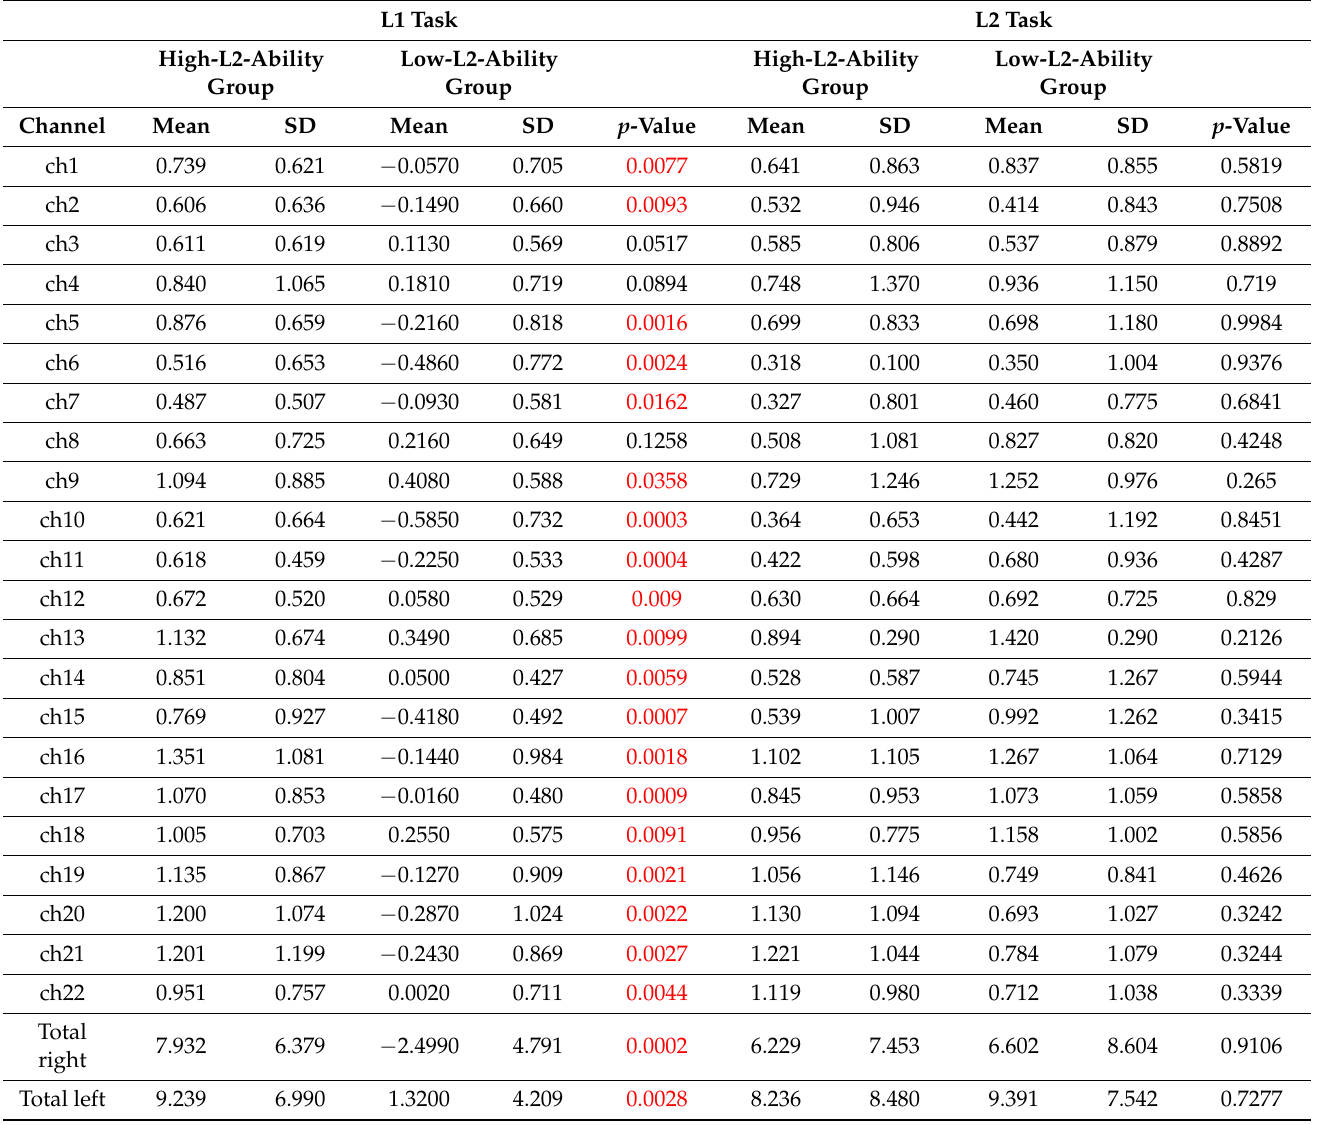
Table 2. Values of ∆ oxy-Hb at 22 channels in high- and low-L2-ability speakers when speaking Mandarin (L1) or Japanese (L2): red indicates significant between-group differences ( p < 0.05).